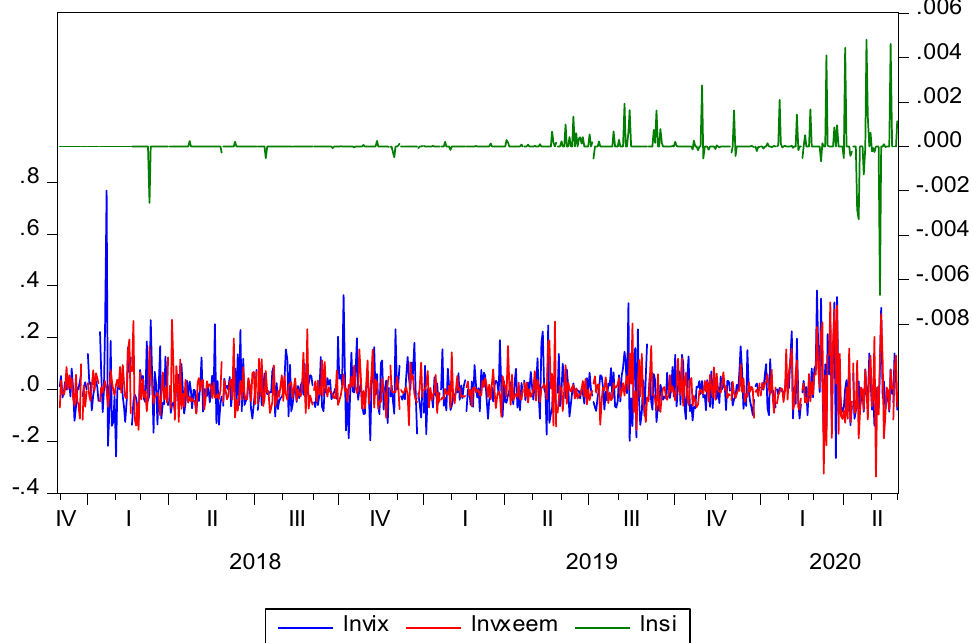
Figure 3. Daily returns of Saudi Sukuk index and volatility indices prices.